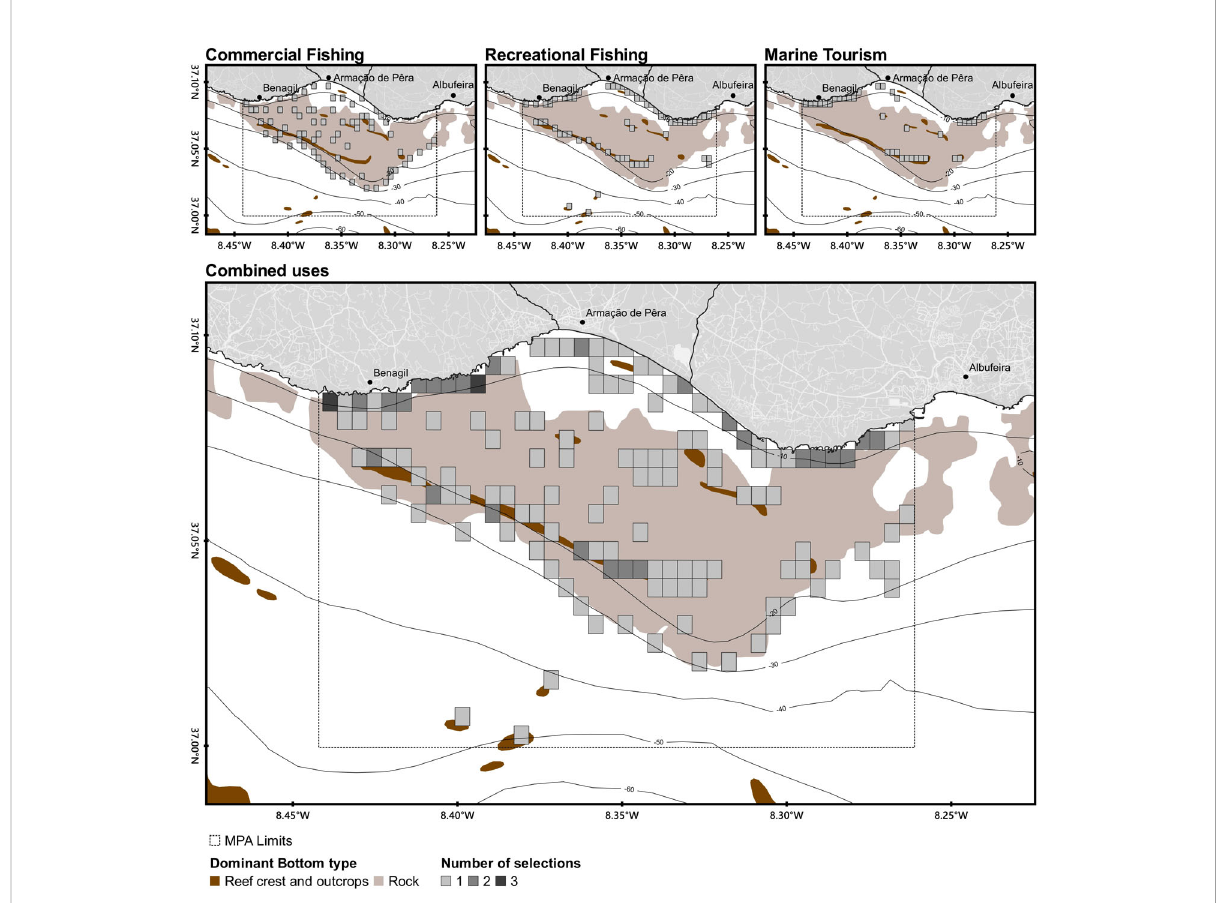
FIGURE 4 Priority sites of use (by the grid), according to the representatives of the local activities (commercial fi sheries, top-left panel; recreational fi sheries, top-centre panel; marine tourism businesses, top-right panel), selected during the users ’ Mapping Workshop. Chosen sites were overlapped, resulting in the bottom panel map: light grey – selected by only one activity; grey – selected by two activities; dark grey – selected by the three activities. Sites selected by two or three activities are assumed as users ’